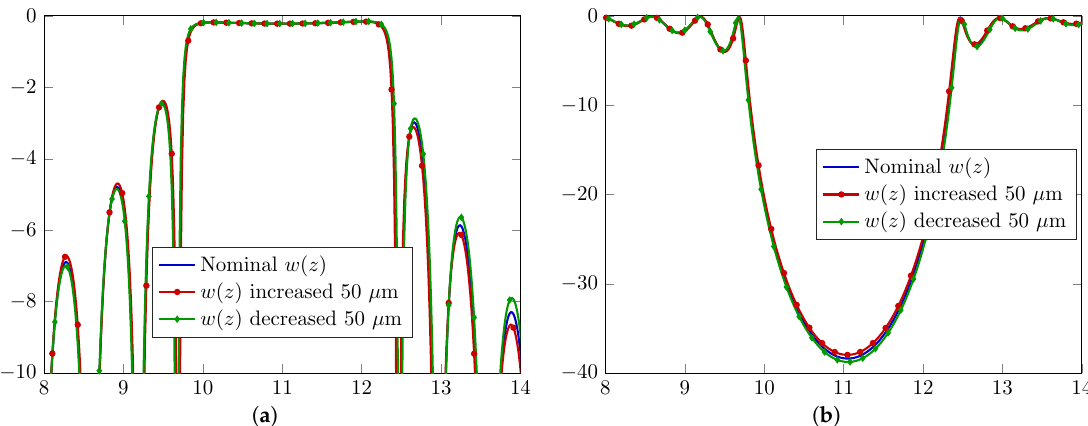
Figure 10. Sensitivity analysis. Comparison between scattering parameters of the filter with nominal value of the width of the inner conductor of the ESICL ( w ( z ) ), and with the width increased and decreased the manufacturing tolerance (50 µ m). ( a ) Reflection. ( b ) Transmission.